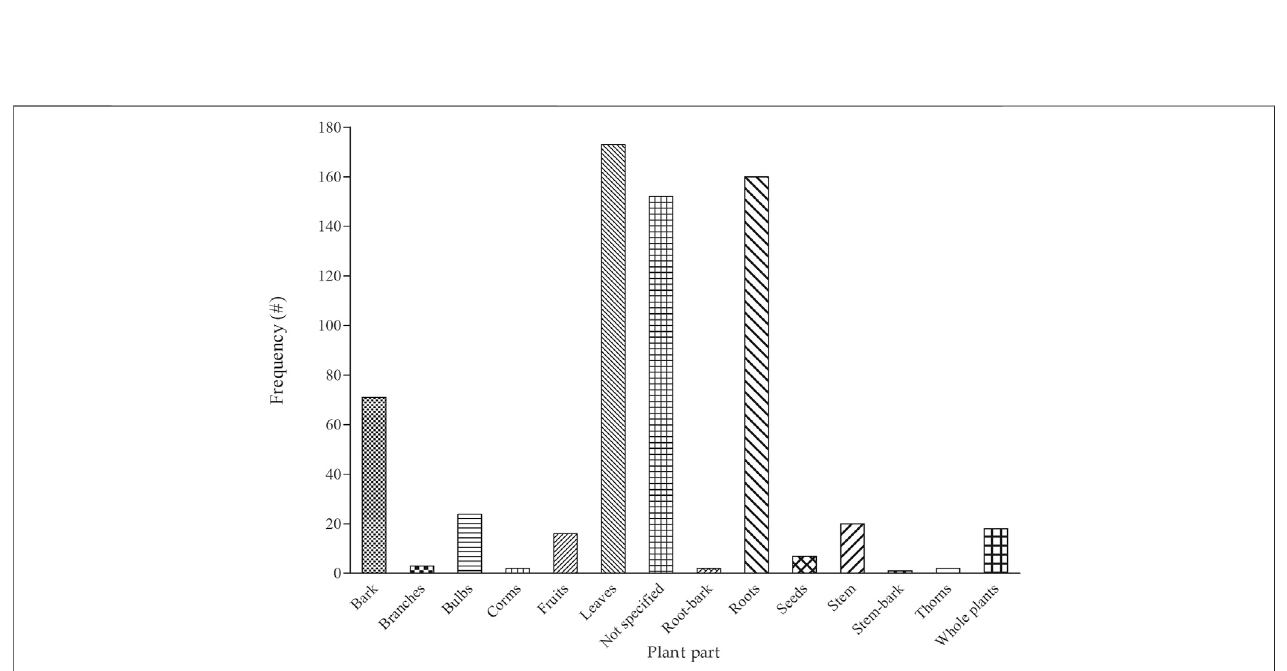
FIGURE5| Distributionofplantpartsindicatedasaremedyforpainandin fl ammatory-relatedconditionsamongdifferentethnicgroupsinSouthAfrica,# (cid:1) number of mentions.